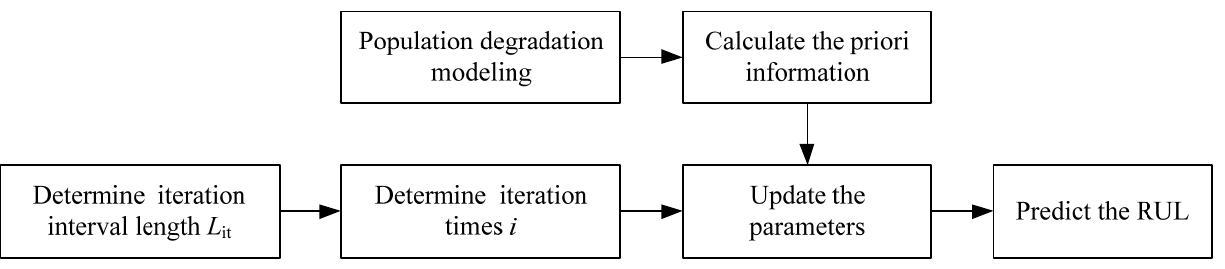
Figure 1. A framework of the heuristic parameter updating algorithm for the remaining useful life (RUL)